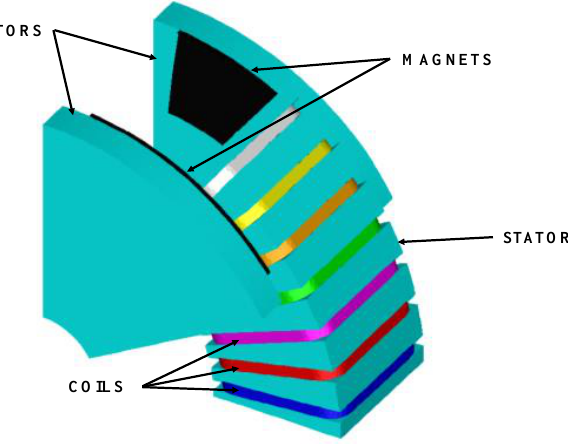
Figure 1. Design of one sixth of the axial flux non-sinusoidal seven-phase PMSM [32].